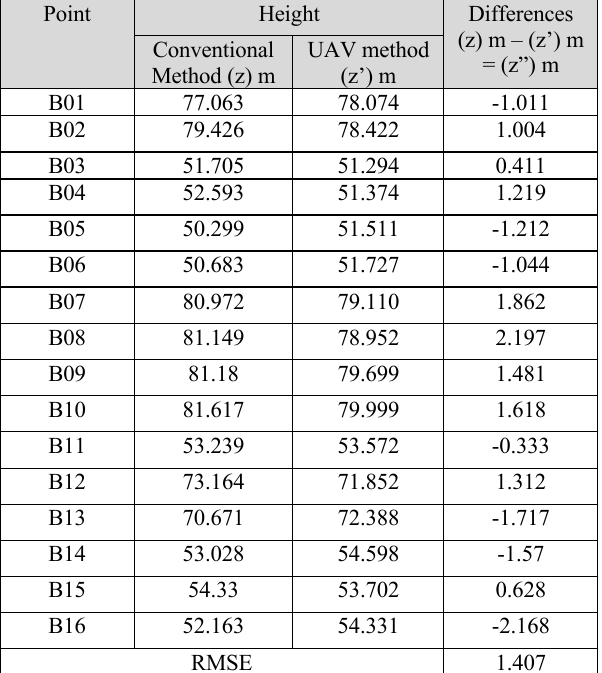
Table 3. Differences between conventional and UAV height